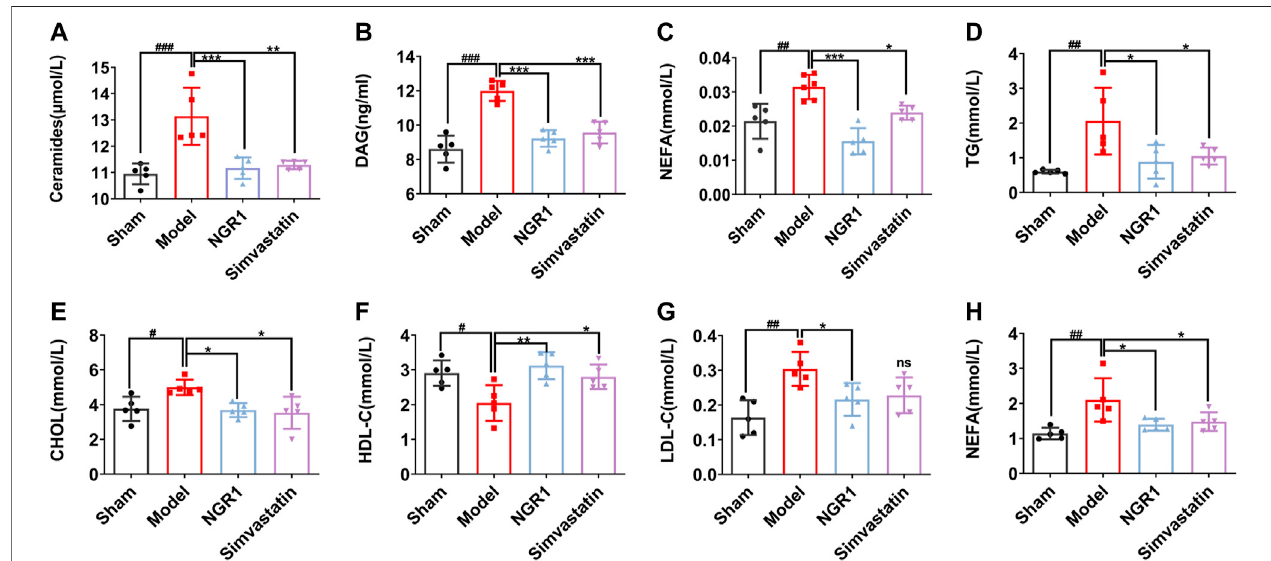
FIGURE 2 | NGR1 regulated serum lipid levels in HF mice model. ELISA was used to detect the levels of lipotoxicity mediators including ceramide, diacylglycerol (DAG)andnon-esteri fi edfattyacids(NEFA)inmyocardialtissue (A-C) .EffectsofNGR1onserum (D) triglyceride(TG) (E) cholesterol(CHOL) (H) highdensitylipoprotein- cholesterol(HDL-C) (G) lowdensitylipoprotein-cholesterol(LDL-C)and (E) Non-esteri fi edfattyacids(NEFA)ofmiceineachgroup.* p < 0.05,** p < 0.01,*** p < 0.001vs. model group, # p < 0.05, ## p < 0.01, ### p < 0.001 vs. sham group, N = 5 per group.